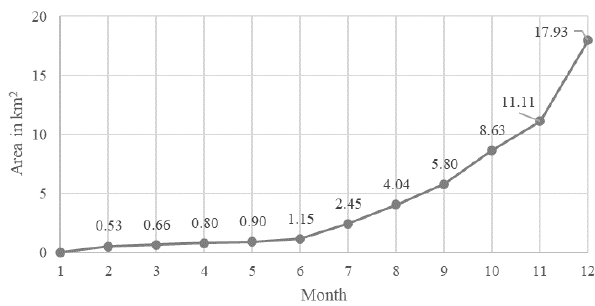
Figure 8. Cumulative forest for 2020, per